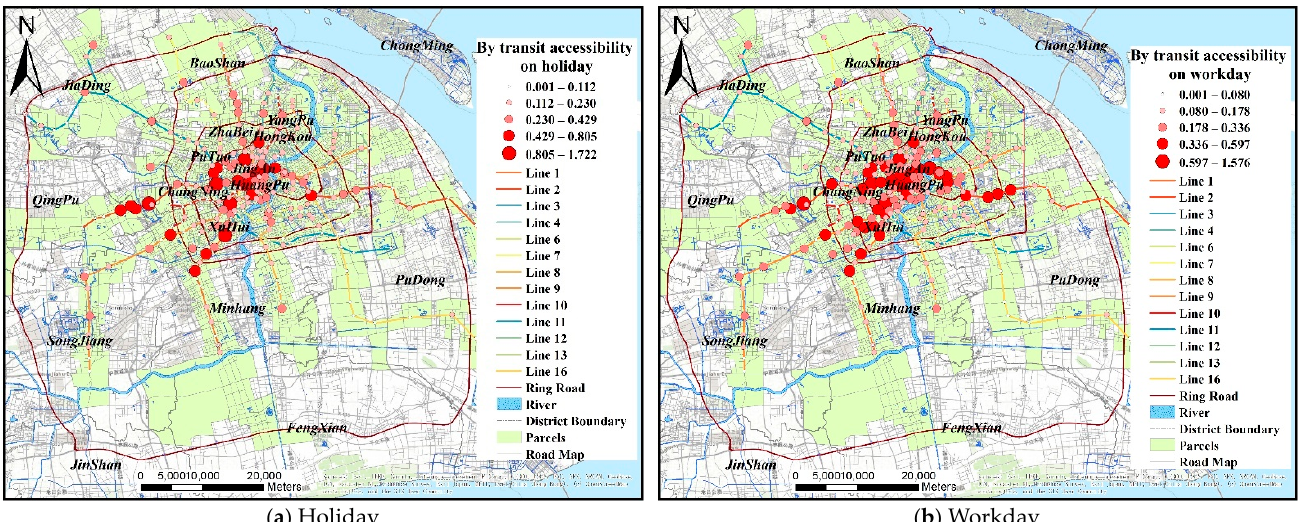
Figure 5. Distribution of transit accessibility by station.